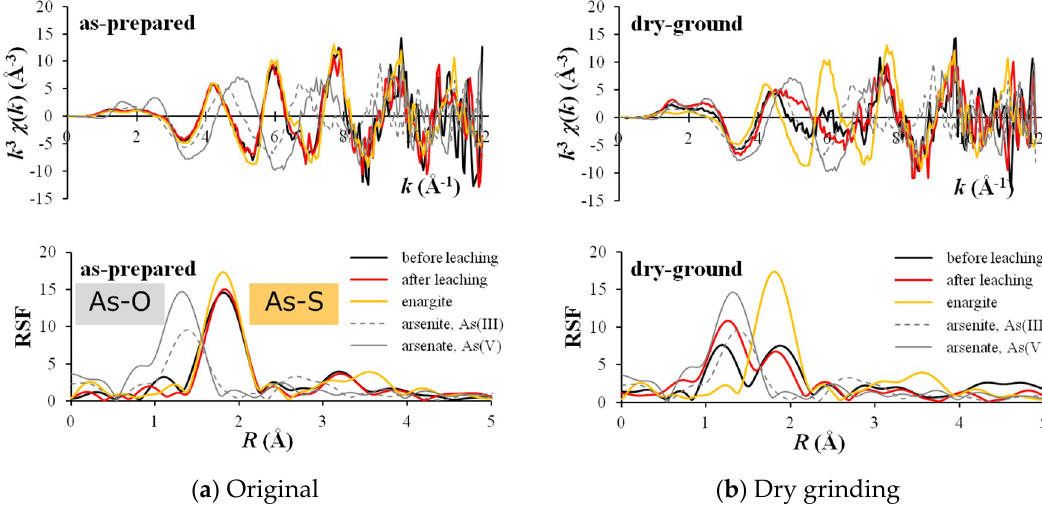
Figure 6. Radial structure functions obtained by Fourier transform of k 3 weighted extended X-ray absorption fine structure (EXAFS) spectra of the ( a ) original and ( b ) dry ground samples.